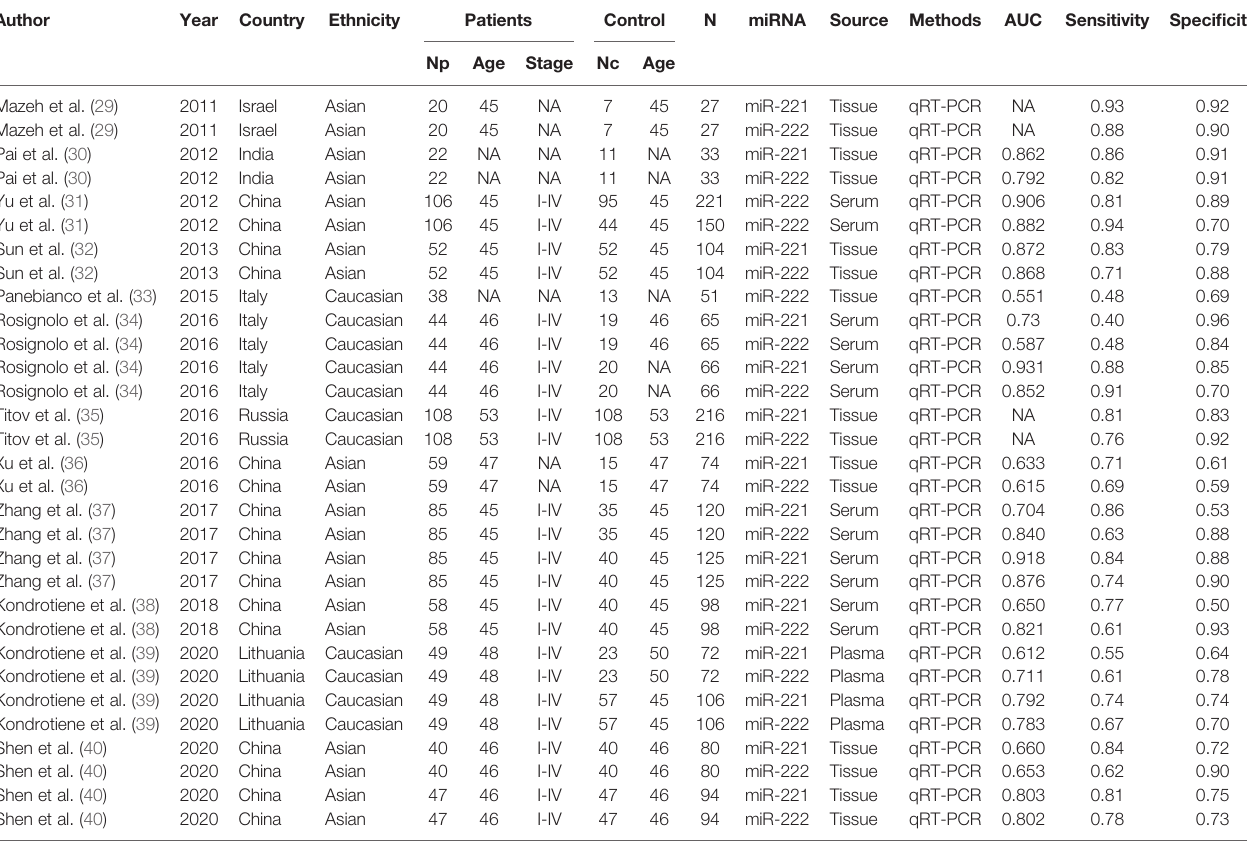
TABLE 1 | The main features of the included studies for miR-221/222 in the diagnosis of